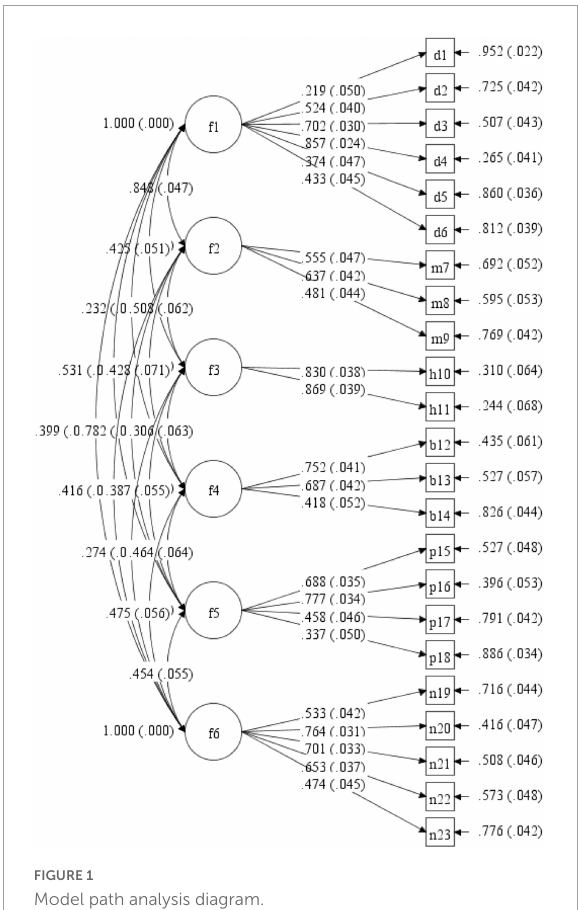
FIGURE1 Model path analysis